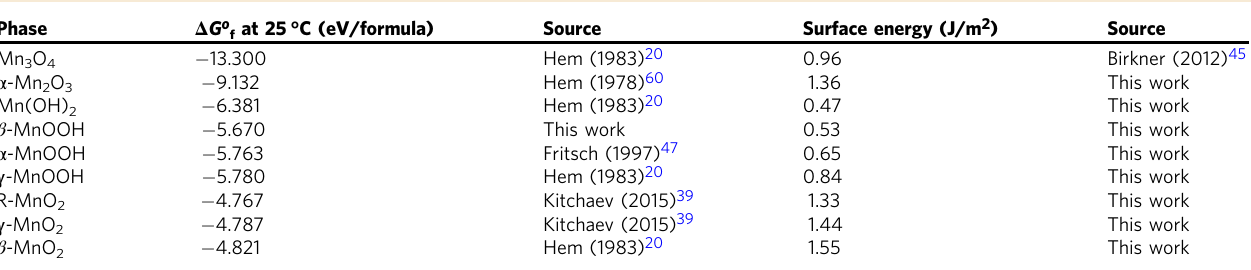
Table 1 Thermochemical data for Mn – H 2 O solids